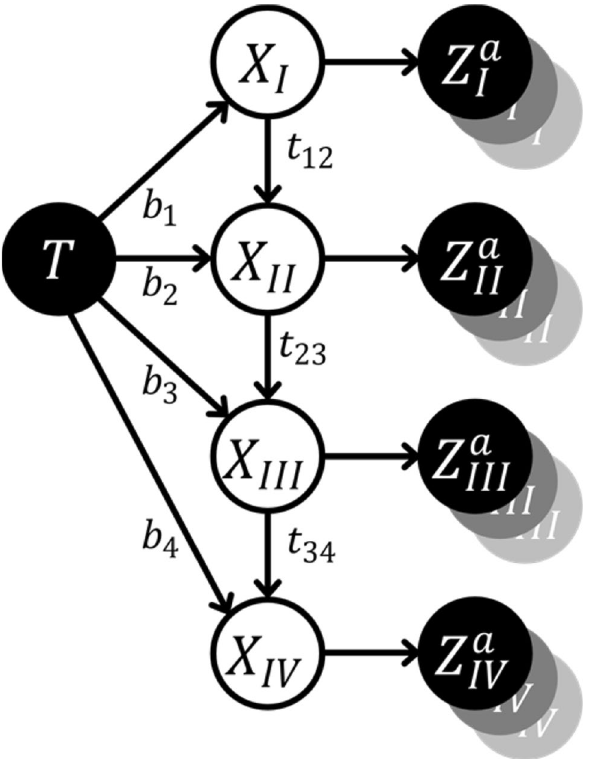
Figure 1. Bayesian network for modelling lymphatic metastatic spread as described by (Pouymayou et al.) 31 . It consists of the primary tumor T , hidden binary variables X v for the involvement of LNL v (white circles) and O O denotes the used diagnostic modality). There are observed (or diagnostic) variables as dark circles ( Z v , where potentially many observations per hidden variable. Annotated arcs depict the direction of lymphatic flow where the parameter next to it ( b and t ) represents the probability of metastatic spread. Not annotated arrows connect the LNLs to their diagnoses via sensitivity and